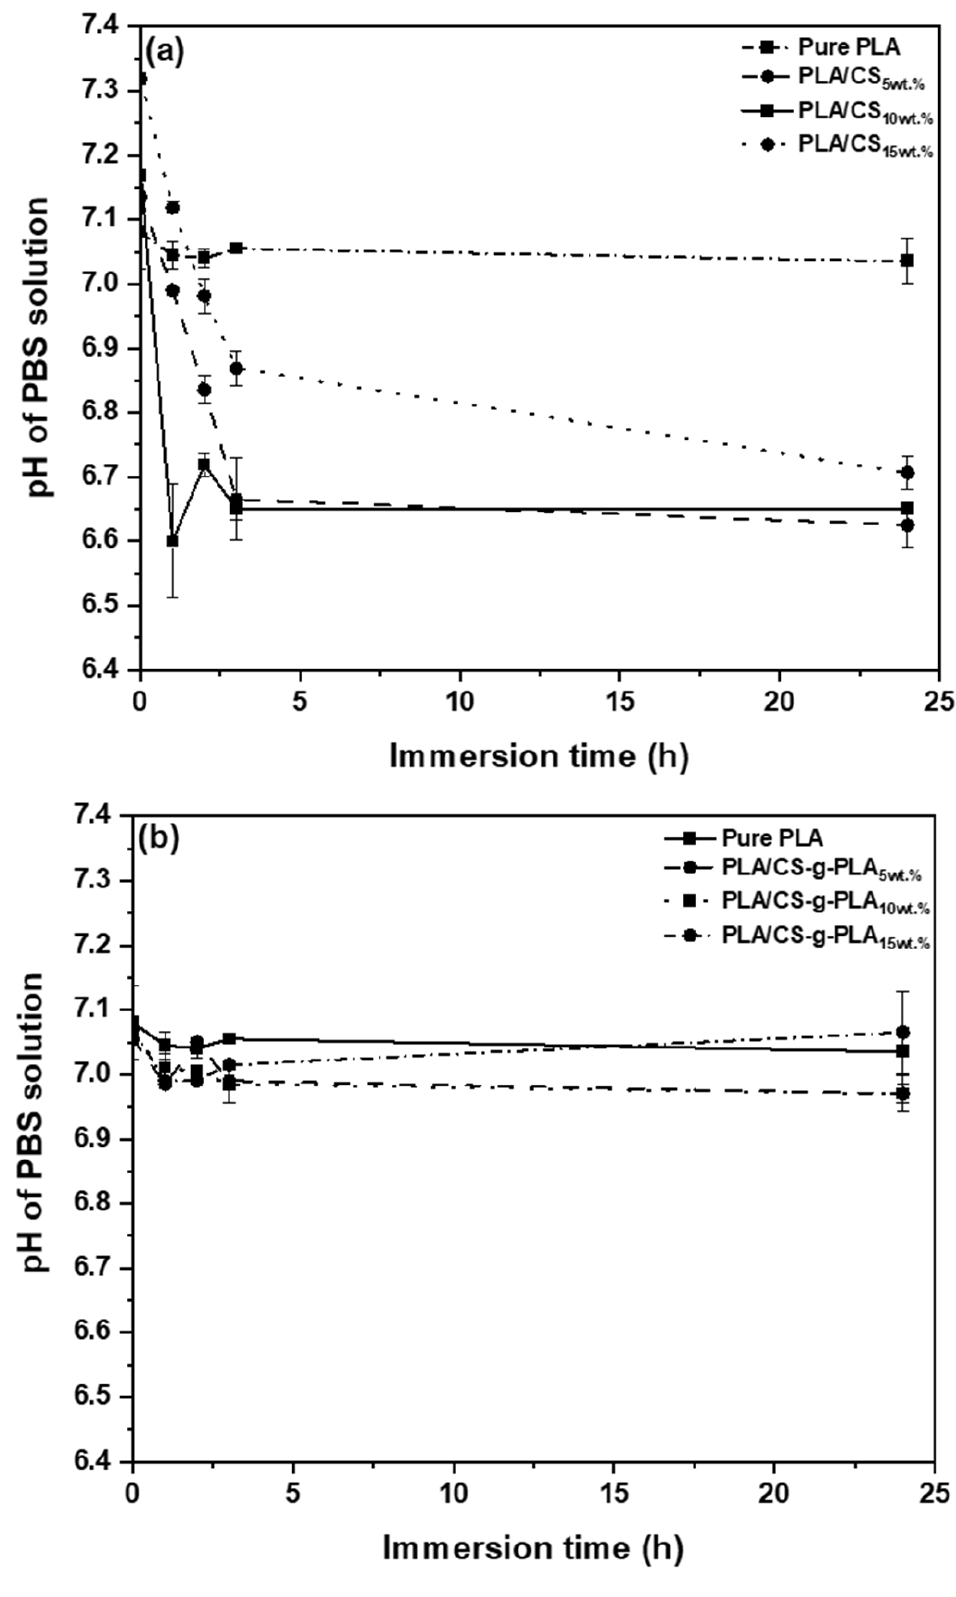
Figure 4. pH of PBS solution as a function of the immersion time of PLA/CS and PLA/CS-g-PLA porous scaffolds: ( a ) PLA/CS 0 – 15wt.% ; ( b ) PLA/CS-g-PLA 0 – 15wt.% .